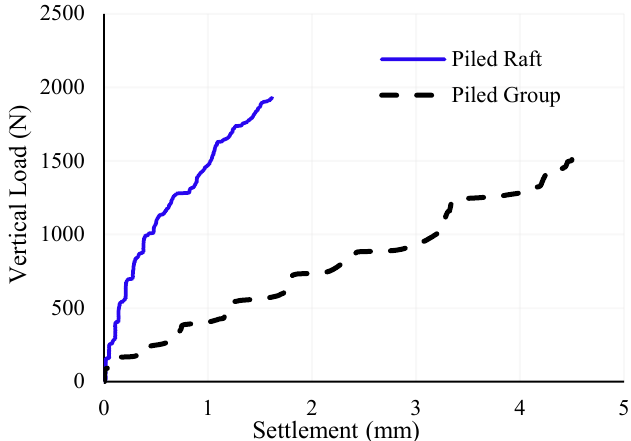
Figure 14. 4-pile group vs. 4-piled raft vertical response.